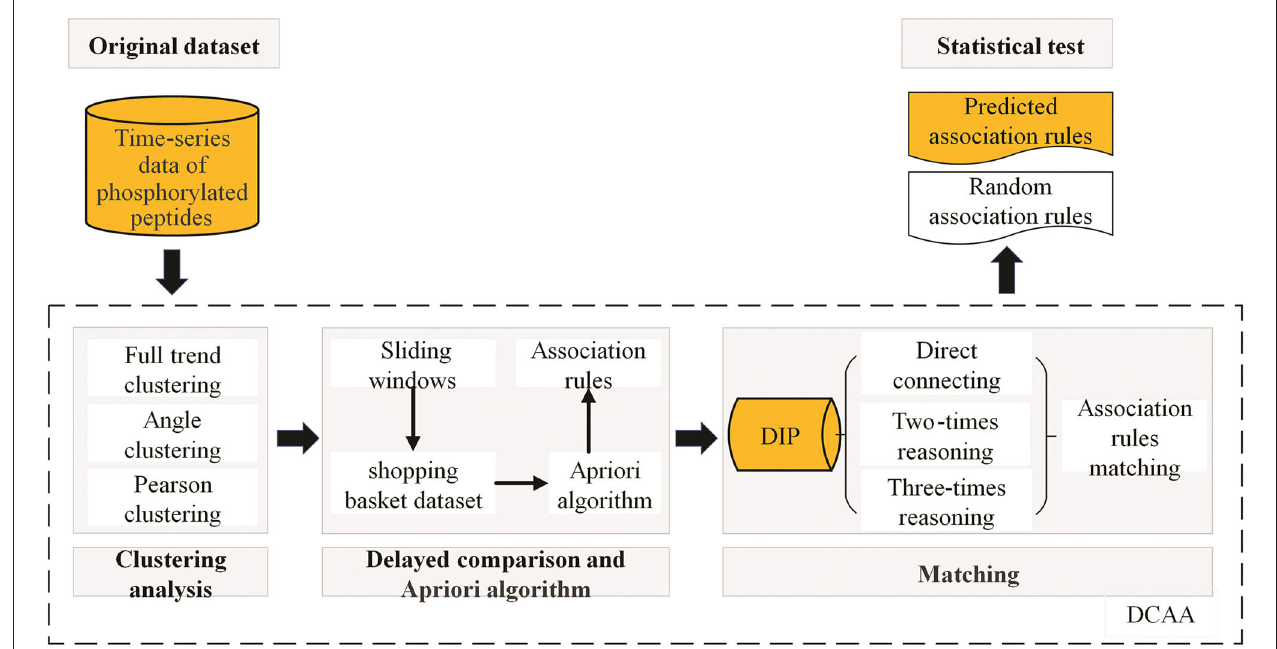
FIGURE 7 | The procedure for the DCAA method. Clustering using different methods was the first step in DCAA analysis. After clustering, the delayed comparison was constructed by using sliding time windows to cover different situations involved in the hysteresis effect. Then, the Apriori algorithm was used to discover association rules for the potential PPIs. Next, the association rules predicted by DCAA and random linking were matched to the association records in the database of interacting proteins (DIP), and the hit rates were calculated. Finally, the hit rates of DCAA and random linking were compared to evaluate the prediction accuracy.